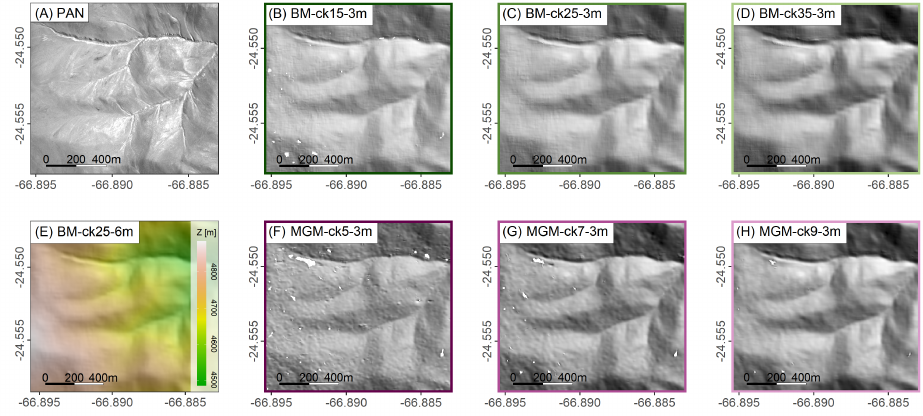
Figure 3. Comparing the map-projected SPOT6 PAN B-scene ( A ) to the resulting stereo DEMs (Table 1) derived from AC pair; ( B – D ) hillshaded DEMs generated using the ASP BM algorithm at increasing CK sizes gridded to a 3 m resolution; ( E ) local topography with an elevation range of ∼ 500 m, taken from the DEM generated using the ASP default parameters and gridded to a 6 m resolution (4 × input-image resolution); ( F – H ) the hillshaded DEMs based on the MGM algorithm with different CK sizes. See Figure 2A for location in study area. Green and purple frame colors correspond to colors in Figures 8 and